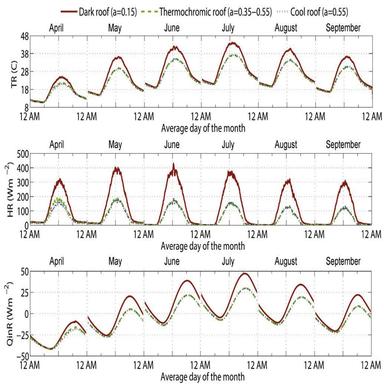
Dark (α = 0.15), thermochromic (α = − 0.35 0.55) and cool (α = 0.55) external roof surface temperature (TR), outward sensible heat flux (HR) and inward heat flux (QinR) monthly-averaged diurnal cycles for the six spring and summer months.